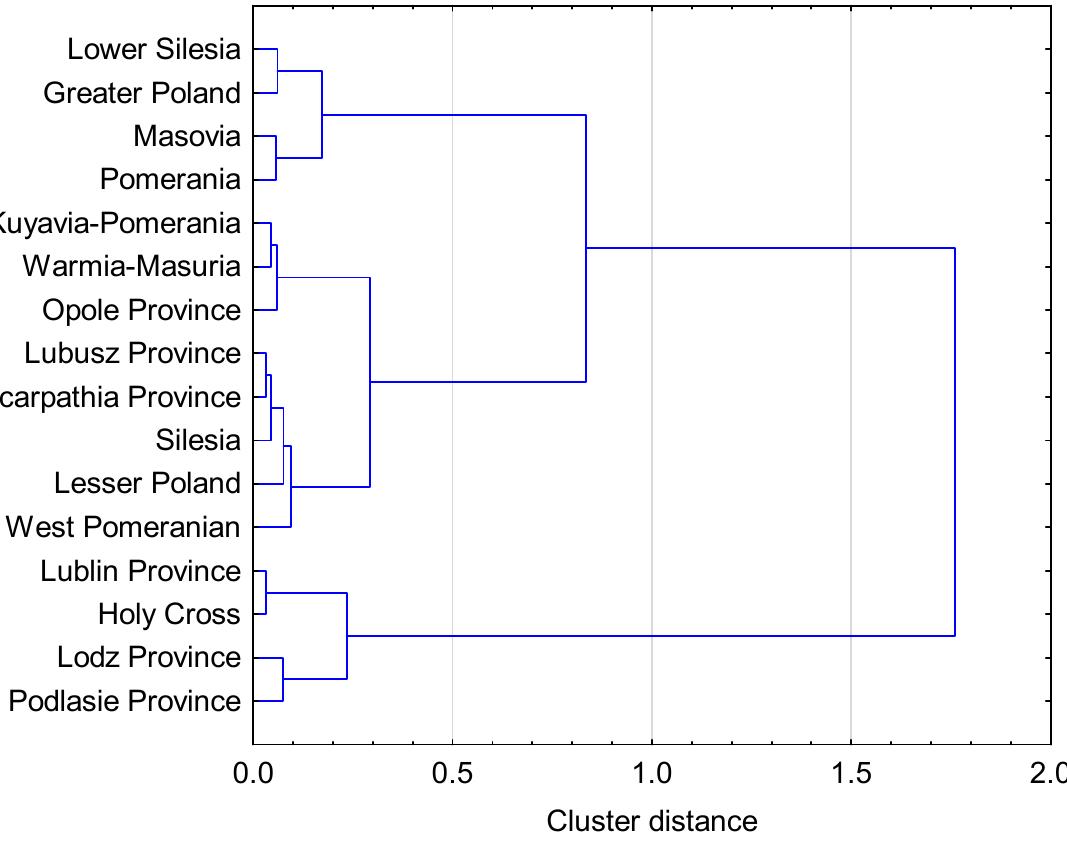
Figure 4. Clusters of Polish voivodships with a similar level of the synthetic measure of the quality of life. Source: own study based on the BDL CSO data.